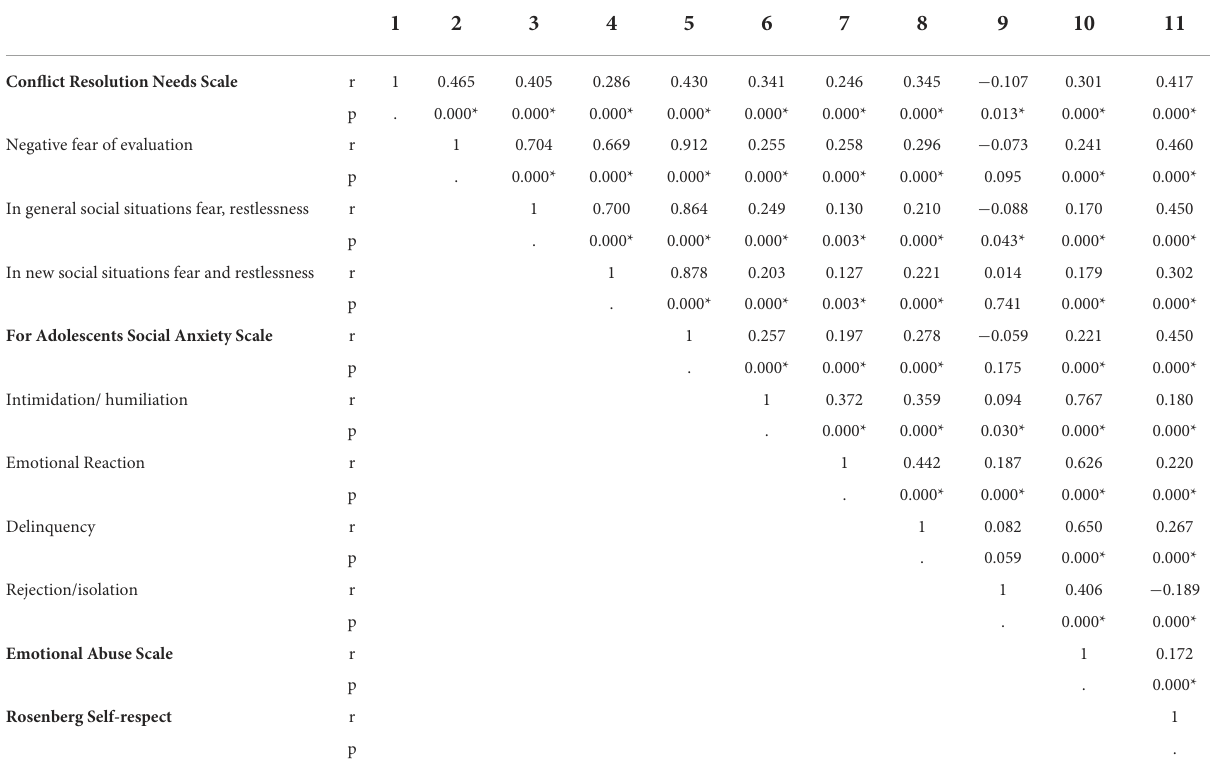
TABLE 3 Relationships between conflict resolution needs of students, social anxiety for adolescents, emotional abuse, Rosenberg Self-Esteem Scores from the scale. 1